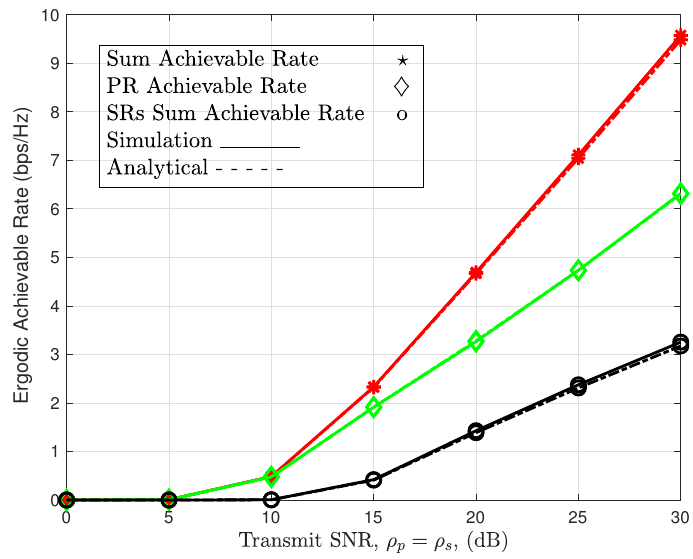
Figure 2. Ergodic achievable rate performance versus transmit SNR.